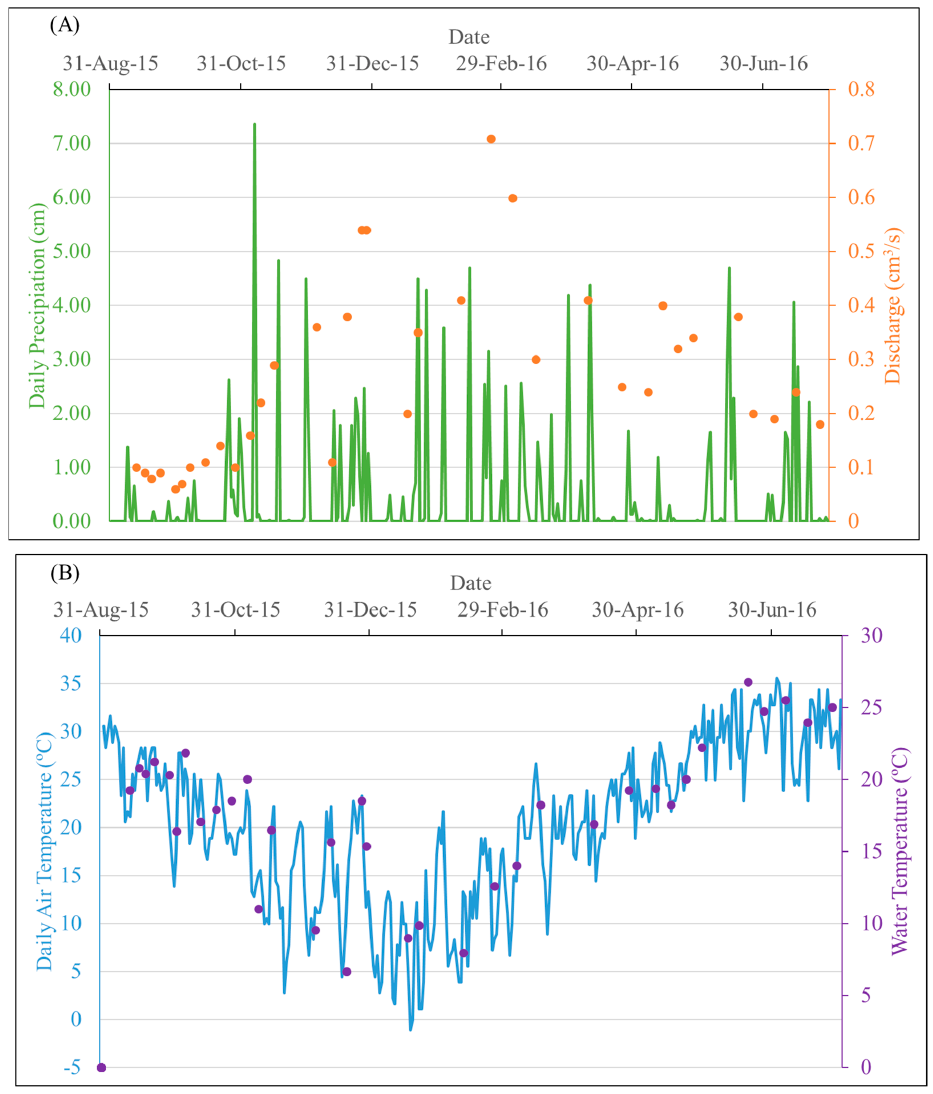
Figure 2. Temperature and hydrological variation of the study area over the study period. ( A ) Daily precipitation of the study area and discharge of the Mayfield Creek on sampling dates; ( B ) daily air temperature of the study area and water temperature of the Mayfield Creek on sampling dates. Daily precipitation and temperature data were acquired from NOAA monitoring station GHCND:USC00018380, which is ~34 km from the sampling site. For inorganic N and P species, nitrate varied from 3.7 to 33.5 µg N/L, ammonium from below detection to 65.1 µg N/L, and phosphate from 1.0 to 4.1 µg P/L. Stable hydrogen ( δ 2 H) and oxygen ( δ 18 O) isotopic values of water fell in the range of − 20.44‰ to 14.22‰ and from − 4.51‰ to 3.73‰, respectively, and they were strongly correlated (Pearson r = 0.90, p < 0.001, df = 32). Sodium concentration fluctuated from 0.71 to 1.38 mg/L, and dissolved silica varied from 3.10 to 4.84 mg/L.